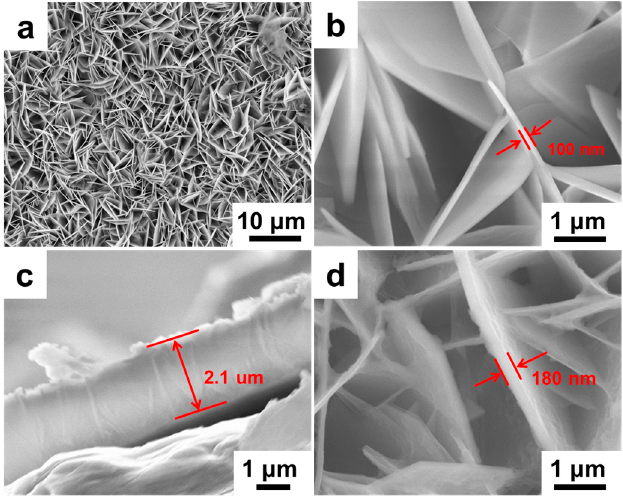
Figure 4. FESEM micrographs of ( a , b ) top-view of CoAl LDH, ( c ) cross-section of CoAl LDH, and ( d ) CoAl LDH-PANI composite.